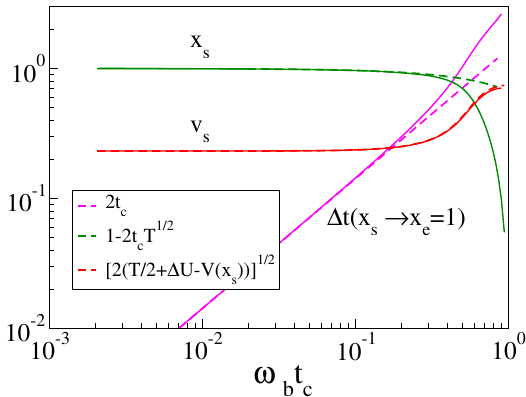
Figure 6: Starting position, starting velocity and time of flight of the maximum of g , illus- t trated in Fig.5, as a function of ω . These quantities (solid lines) depart from the free flights b c overdamped picture prediction (dashed lines) on approaching the crossover from the over- = 1, where the maximum of g is replaced by a t damped to the underdamped regime, ω b c divergence. The energy scale of the overdamped flights is T /